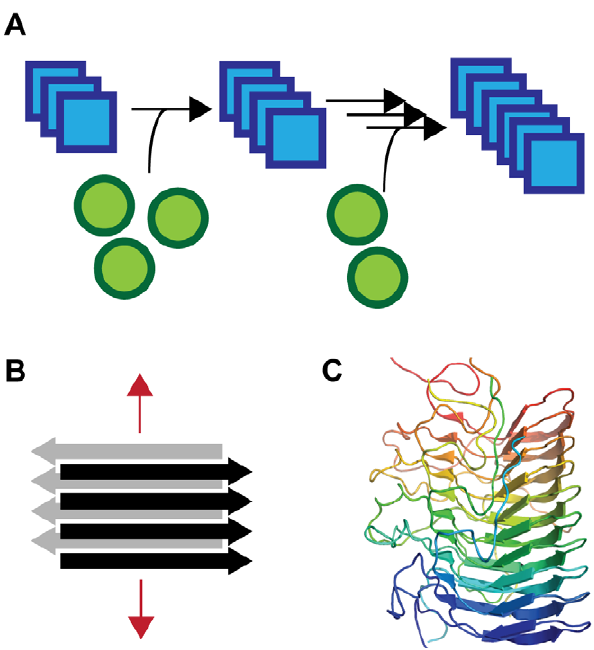
Figure 1. Prions are self-perpetuating protein structures that typically take the form of amyloid aggregates. A prion is a protein that can exist in two (or more) structures, one of which is self- replicating. (A) In the example shown, the prion or amyloid form of the protein (in blue) can convert the non-prion conformation (in green) to the prion form. Eventually, most of the non-prion protein is converted to the prion form. (B) Amyloid, which is a common prion structure, comprises a range of fibrous aggregates. Amyloid aggregates have related structures composed of stacked b -sheets ( b -strands are represented by horizontal arrows), wherein the strands are oriented perpendicular to the fiber axis (indicated by the red arrow). Two antiparallel b -sheets are shown. (C) The Het-s prion is an amyloid aggregate that has a well-defined b -solenoid structure, as determined by solid-state NMR (PDB 2RNM) [25].